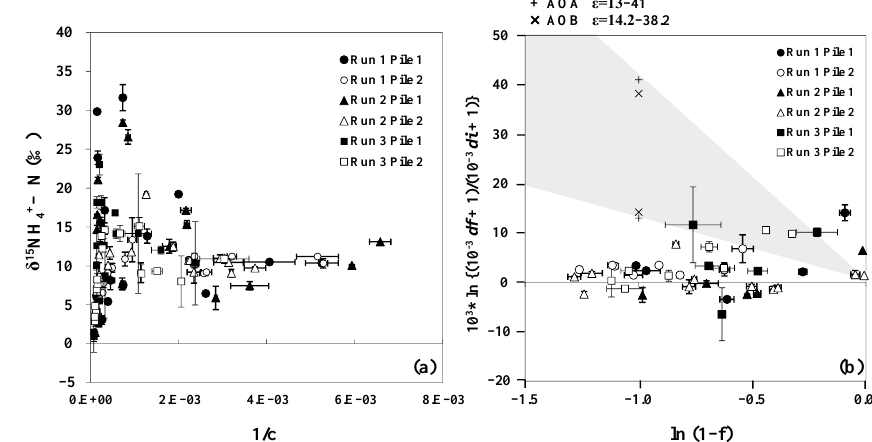
Figure 4. Keeling plot (a) and Rayleigh plot (b) of the δ 15 NH + –N. The error bars indicate the standard deviation ( n = 2). Black symbols 4 indicate the compost with bulking agent (10% w/w ) and white symbols indicate the compost without bulking agents. The gray zone indicate the area which can be explained by ammonium oxidation by AOB (ammonia oxidizing bacteria; 14.2–38.2‰) or AOA (ammonium oxidizing archaea; 13–41‰).